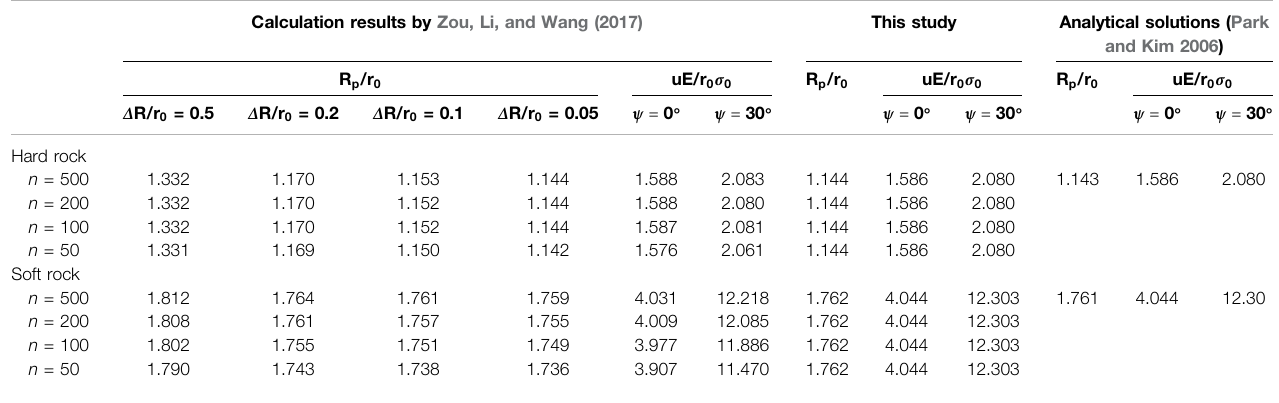
TABLE 2 | Calculation results for different elasto-plastic analysis methods. Calculation results by Zou, Li, and Wang (2017) This study Analytical solutions (Park